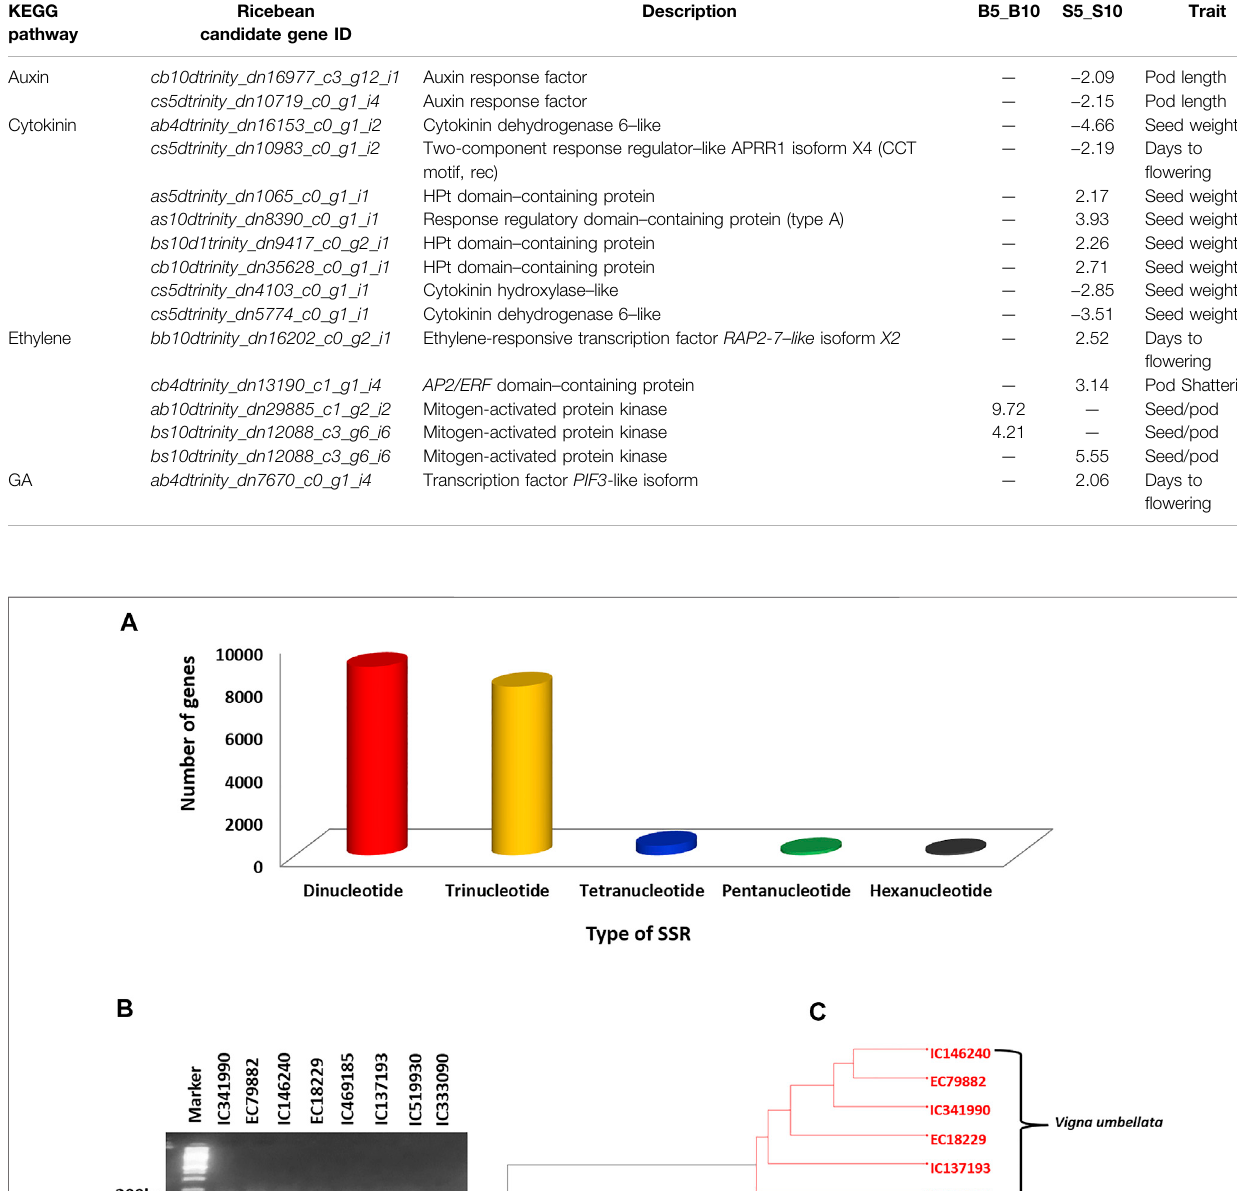
Frontiers in Genetics |